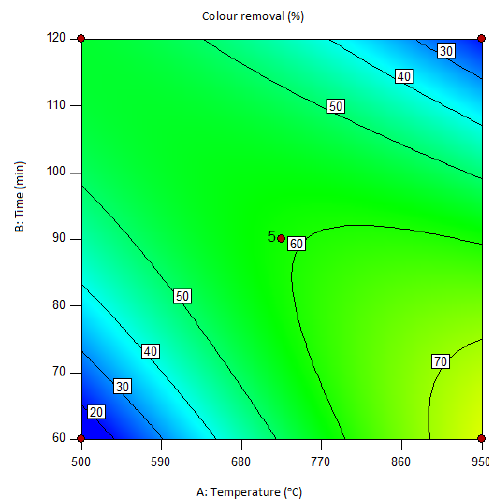
Fig. 5. Time and temperature effects on colour removal (%)